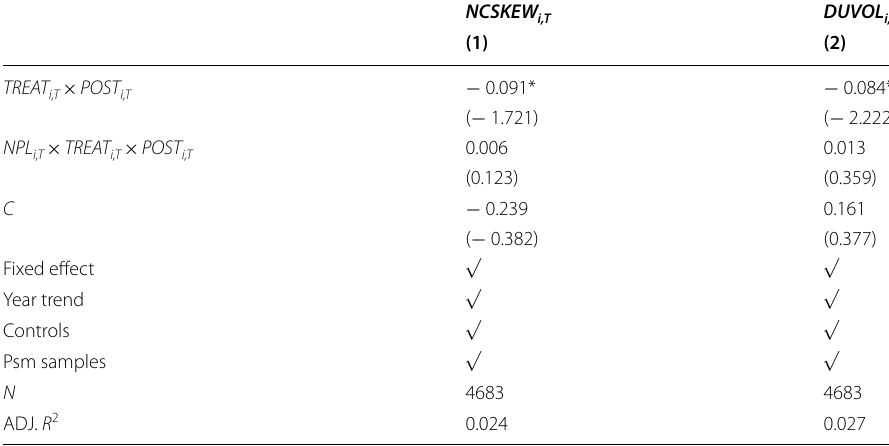
In this paper, ***, **, and * represent the significance levels of 1%, 5%, and 10%, respectively. The t-value is in parentheses. The t-value is in parentheses. After the implementation of the New Environmental Protection Law in 2015, NPL is recorded as 1, otherwise it is 0